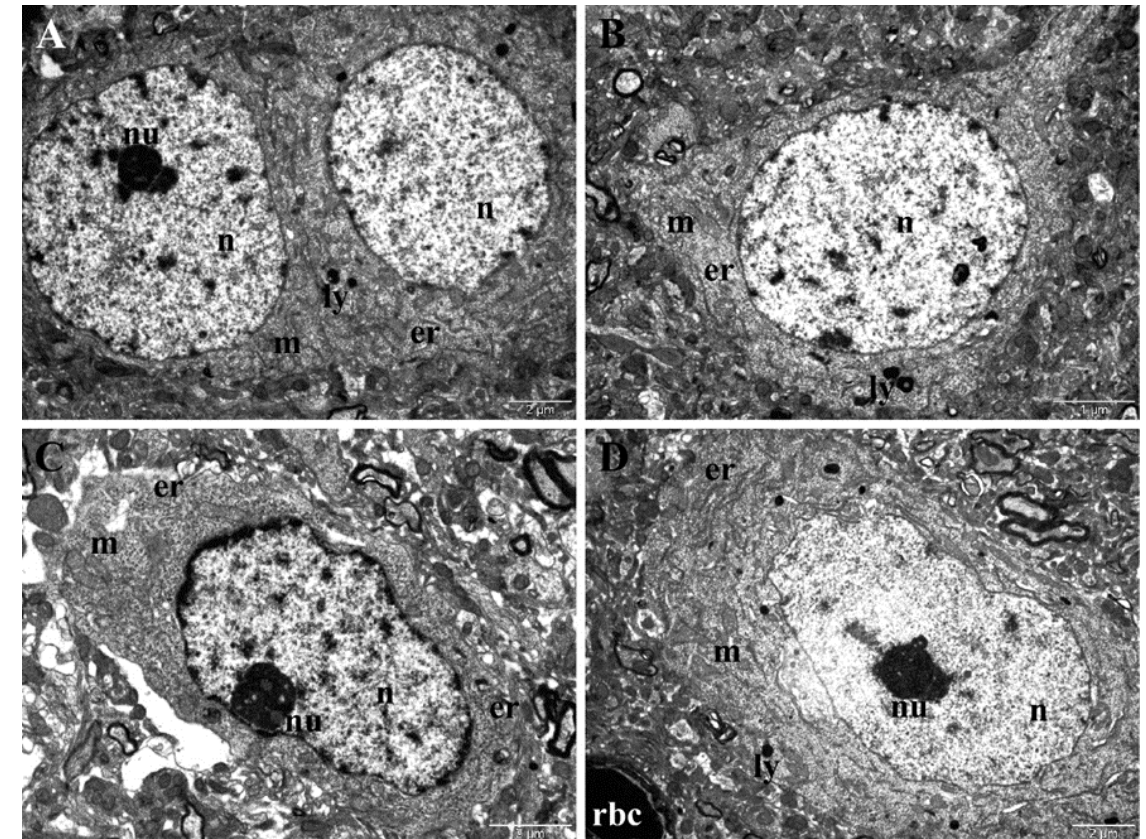
Figure 9. ( A , B ) TEM images showing normal ultrastructure of neurons in the frontal cortex of control group. ( C , D ) TEM images showing normal ultrastructure of neurons in the hippocampus ( C , D ) of control group. Er–endoplasmic reticulum; ly–lysosome; m–mitochondrion; n–nucleus; nu–nucleolus; rbc–red blood cell.